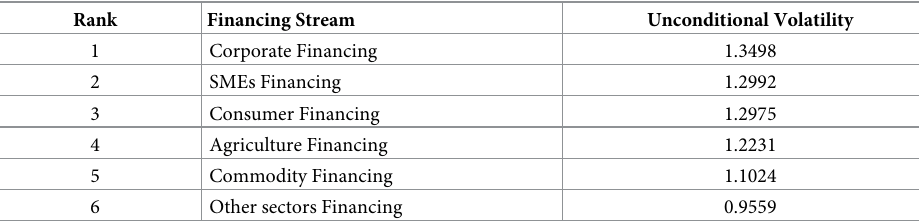
Table 8. Conditional correlations of interest rate with Islamic